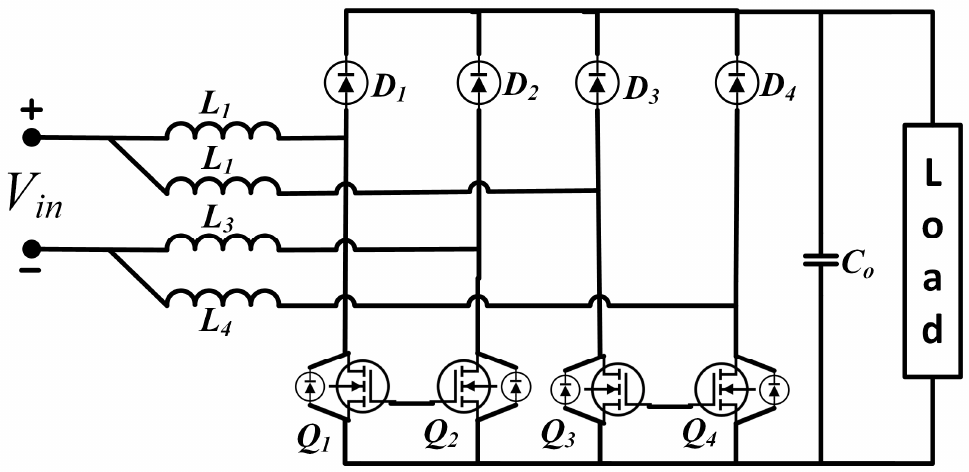
Figure 47. Bridgeless Interleaved Boost PFC Converter [46].